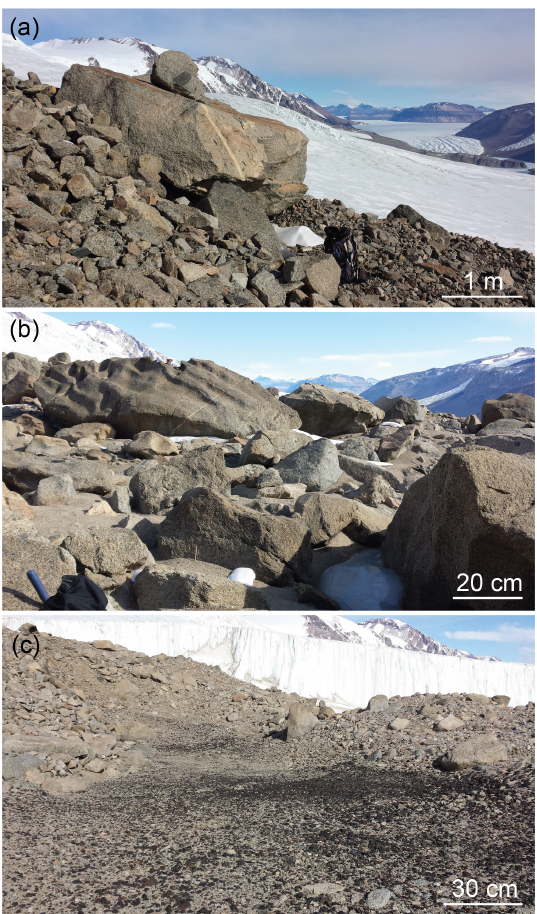
Figure 6. Surface lithology and weathering trend going down the rock glacier. (a) Upper rock glacier, showing fresh, angular granitic boulders and cobbles. (b) Central rock glacier, showing rounded and ventifacted granitic boulders and a granitic grus ground cover. (c) Lower rock glacier, showing smaller clast sizes and poorly de- veloped desert pavement in a small depression with mixed granitic and basalt ground cover.